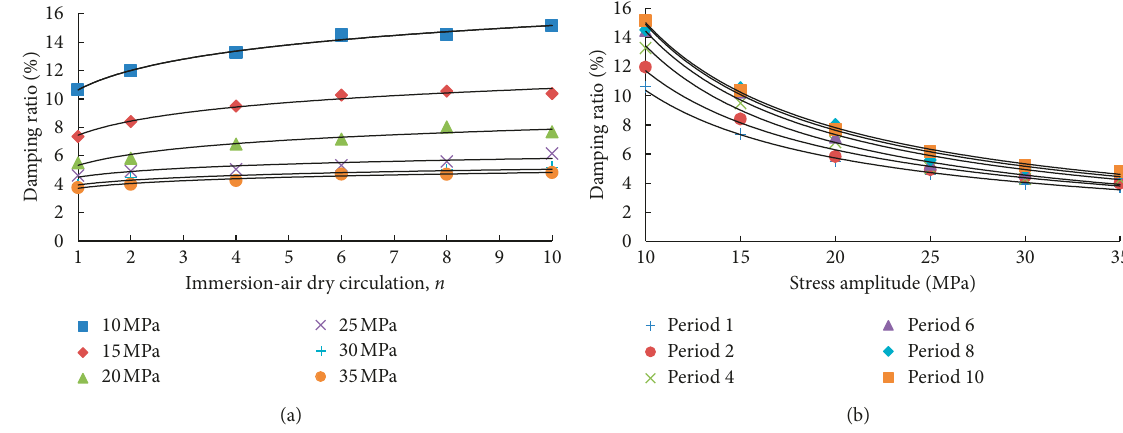
Figure 9: Damping ratio variation curves of the rock sample under water-rock interaction. (a) The relation curve of damping ratio with water-rock cycle. (b) The relation curve of damping ratio with cyclic load stress